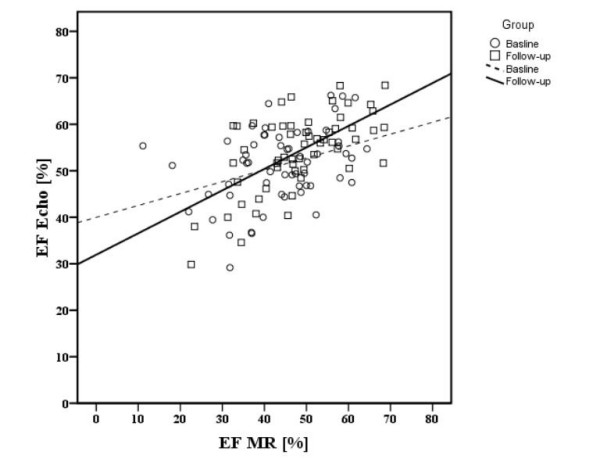
Correlation of EFecho and EFCMR at baseline and at 4-month follow-up. Figure 1 shows the correlation of EF (ejection fraction) between echo and CMR at baseline (dashed line, r: 0.326; p < 0.01) and at follow-up (continuous line, r: 0.479; p < 0.001). At follow-up echocardiography correlates better with CMR than at baseline.